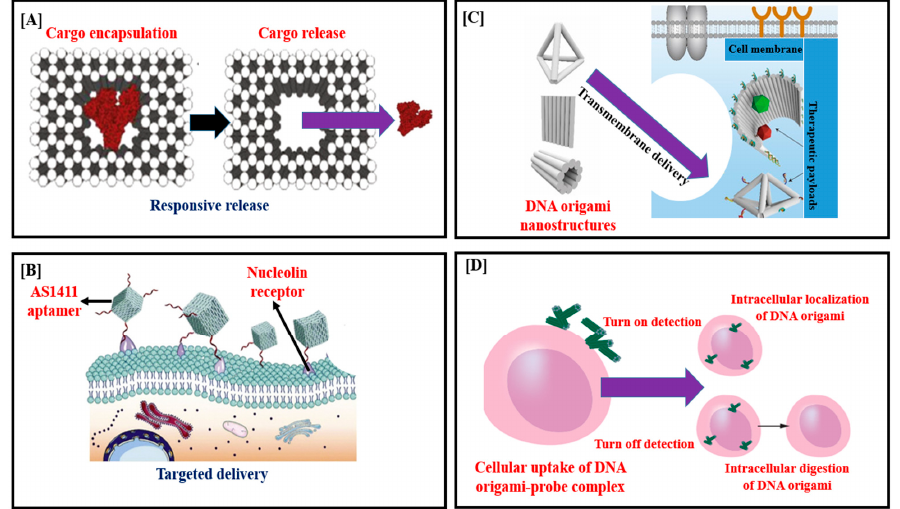
Figure 4. ( A ) The application of light-cleavable linkers allows for the responsive release of drugs from DNA origami nanostructures. ( B ) DNA origami can be delivered to nucleolin receptor-expressing tumor cells using nucleolin receptor-specific aptamers. ( C ) Biological function regulation by DNA origami nanostructures at cell interface. ( D ) Following the formation of the DNAorigami–probe complex, DNA origami can be delivered to the cells, and its intracellular location and breakdown can be detected using fluorescence microscopy. To explore their cell transport activities, DNA origami nanostructure carriers are frequently tagged with fluorescent dyes. Because such fluorescent dyes are observable Table 1. List of selected functionalized DNA origami nanostructures used in the recent literature with their diameter, length, therapeutic agent, cell lines, targeted model, and targeted sites.